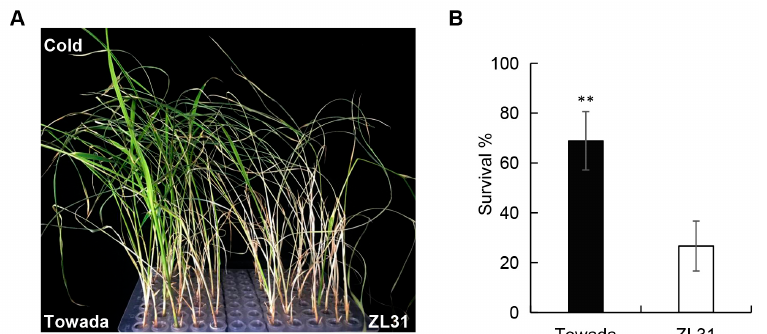
Figure 1. Identification of cold sensitivity of Towada and ZL31 in the seedling stage. ( A ) ZL31 was more sensitive to cold in the seedling stage under 4 ℃ cold treatment. ( B ) Comparative survival rate of seedlings of Towada and ZL31 under 4 ℃ cold treatment. A t -test was used to analyze the differences between means, presented as mean ± standard deviation, where ** shows that p < 0.01.